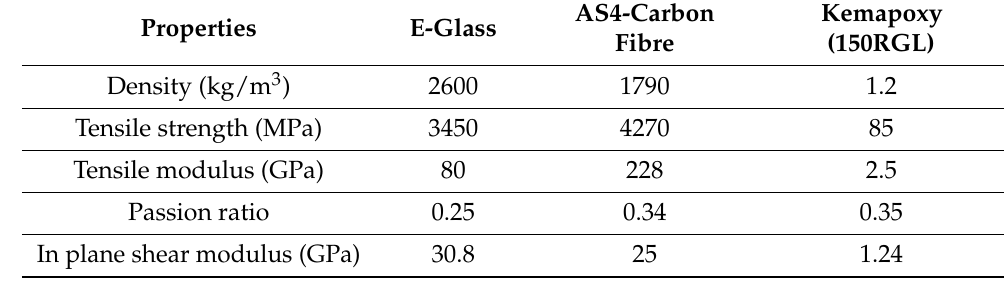
Table 1. Mechanical and physical properties of E-glass fibre and epoxy resin [54–56].